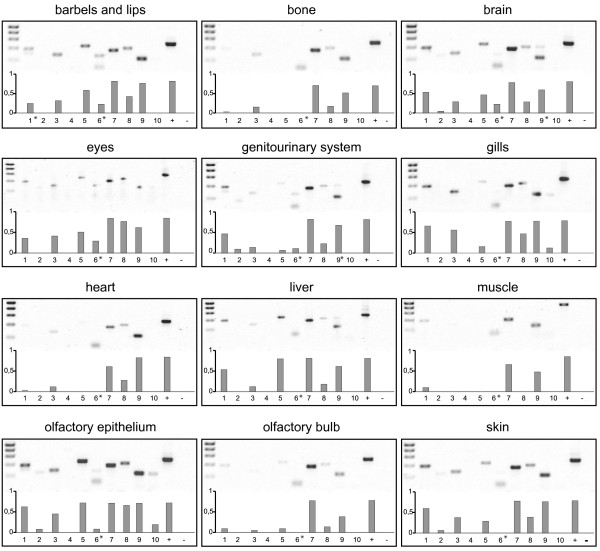
Expression of ten s100 genes in adult zebrafish by RT-PCR. mRNA was extracted from adult zebrafish tissue and transcribed into cDNA. Primer positions for PCR see Materials and Methods. Twelve different tissues were examined (barbels and lips, bone, brain, eyes, genitourinary tissue, gills, heart, liver, muscle, olfactory bulb, olfactory epithelium, skin). Band intensity was quantified to obtain an estimate of abundance to compare expression levels of several genes at least within the same tissue. Asterisks indicate bands at unexpected size (resulting from unspecific amplification) that were not quantified.